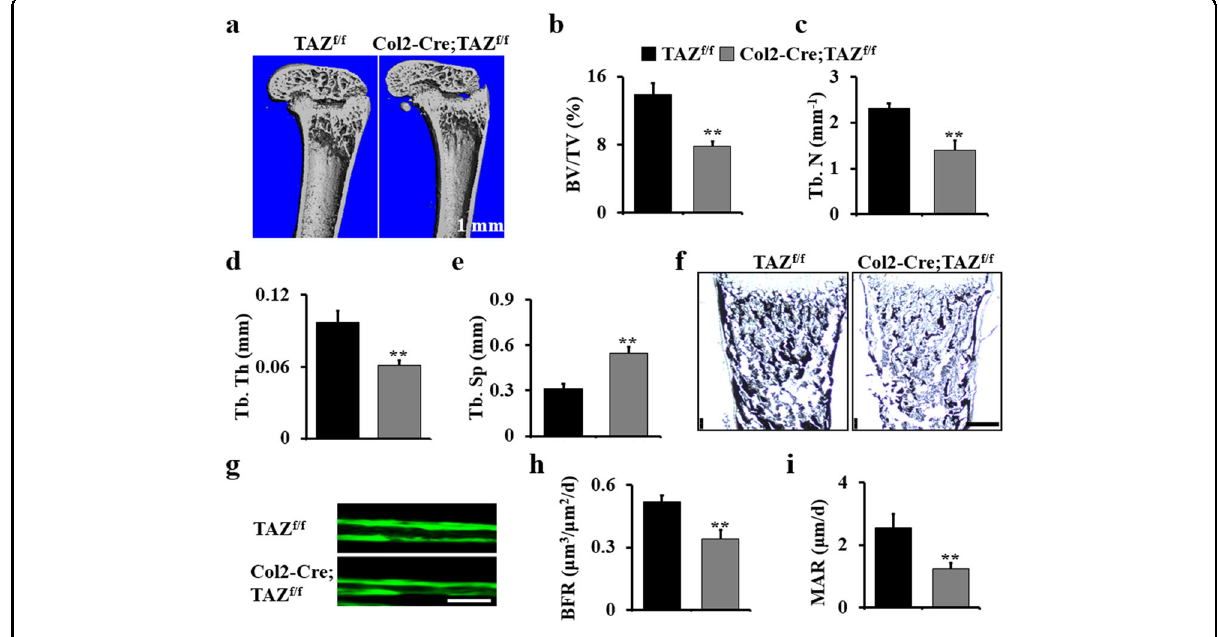
Fig. 3 Deletion of TAZ in chondrocytes impairs bone development. a Representative micro-CT reconstructions of the femurs of Col2-Cre;TAZ f/f mice and controls at 1 month. Scale bars, 1 mm. b – e Histomorphometric analysis of bone parameters in the femur of Col2-Cre;TAZ f/f and control mice ( n = 5 mice per group). Bone volume fraction (BV/TV) ( b ); trabecular thickness (Tb.Th) ( c ); trabecular number (Tb.N) ( d ); trabecular spacing (Tb. Sp) ( e ). f Representative von Kossa staining of terminally differentiated hypertrophic chondrocytes in the tibiae of mice at E18.5 ( n = 3 mice per group). Scale bars, 75 μ m. g – i Calcein double labeling in tibia of 2-month-old Col2-Cre;TAZ f/f mice and controls. The mice were injected with calcein twice with an interval of 7 days. The mice were sacri fi ced 1 day after the second injection. The tibia bones were embedded, sectioned, and the images were taken using a microscope. h Bone formation rate (BFR); i mineral apposition rate (MAR). n = 5 mice per group. The experiment was repeated three times independently. Error bars were the means ± SEM of triplicates from a representative experiment. ** P <